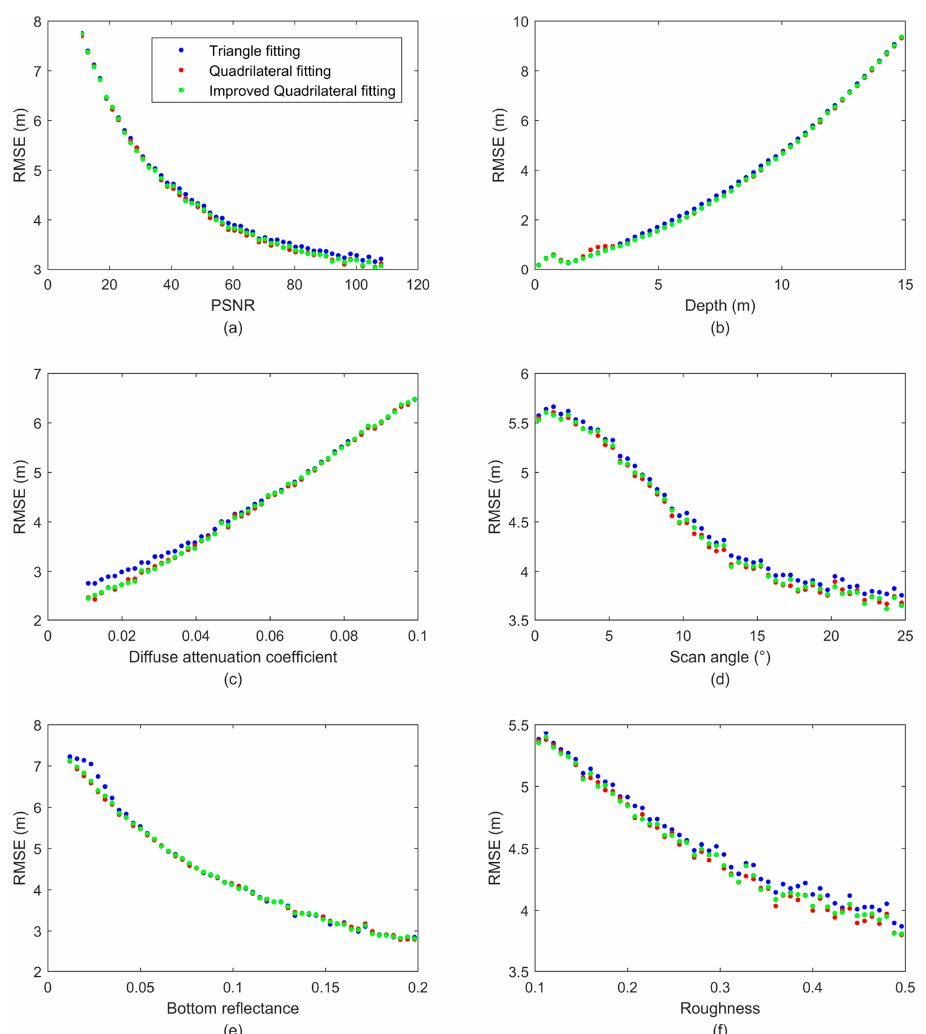
Figure 4. The RMSE changes in the function of one parameter: ( a ) PSNR; ( b ) Depth; ( c ) Diffuse attenuation coefficient; ( d ) Scan angle; ( e ) Bottom reflectance, and ( f ) Roughness. Table 5. The PSNR distribution of the averaged RMSE values for the three algorithms.